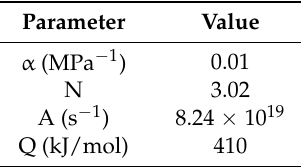
. ε . ε Figure 3. Plots of ( a ) lnε(cid:4662) vs. lnσ ; ( b ) lnε(cid:4662) vs. σ ; ( c ) ln(cid:4670)sinh(ασ)(cid:4671) vs. lnε(cid:4662) ; ( d ) ln(cid:4670)sinh(ασ)(cid:4671) vs. (cid:2869) Figure 3. Plots of ( a ) ln vs. ln σ ; ( b ) ln vs. σ ; ( c ) ln [ sinh ( ασ )] vs. ln Table 4. Constants and activation energy of the Fe-6.5wt. %Si alloy. Table 4. Constants and activation energy of the Fe-6.5wt. %Si